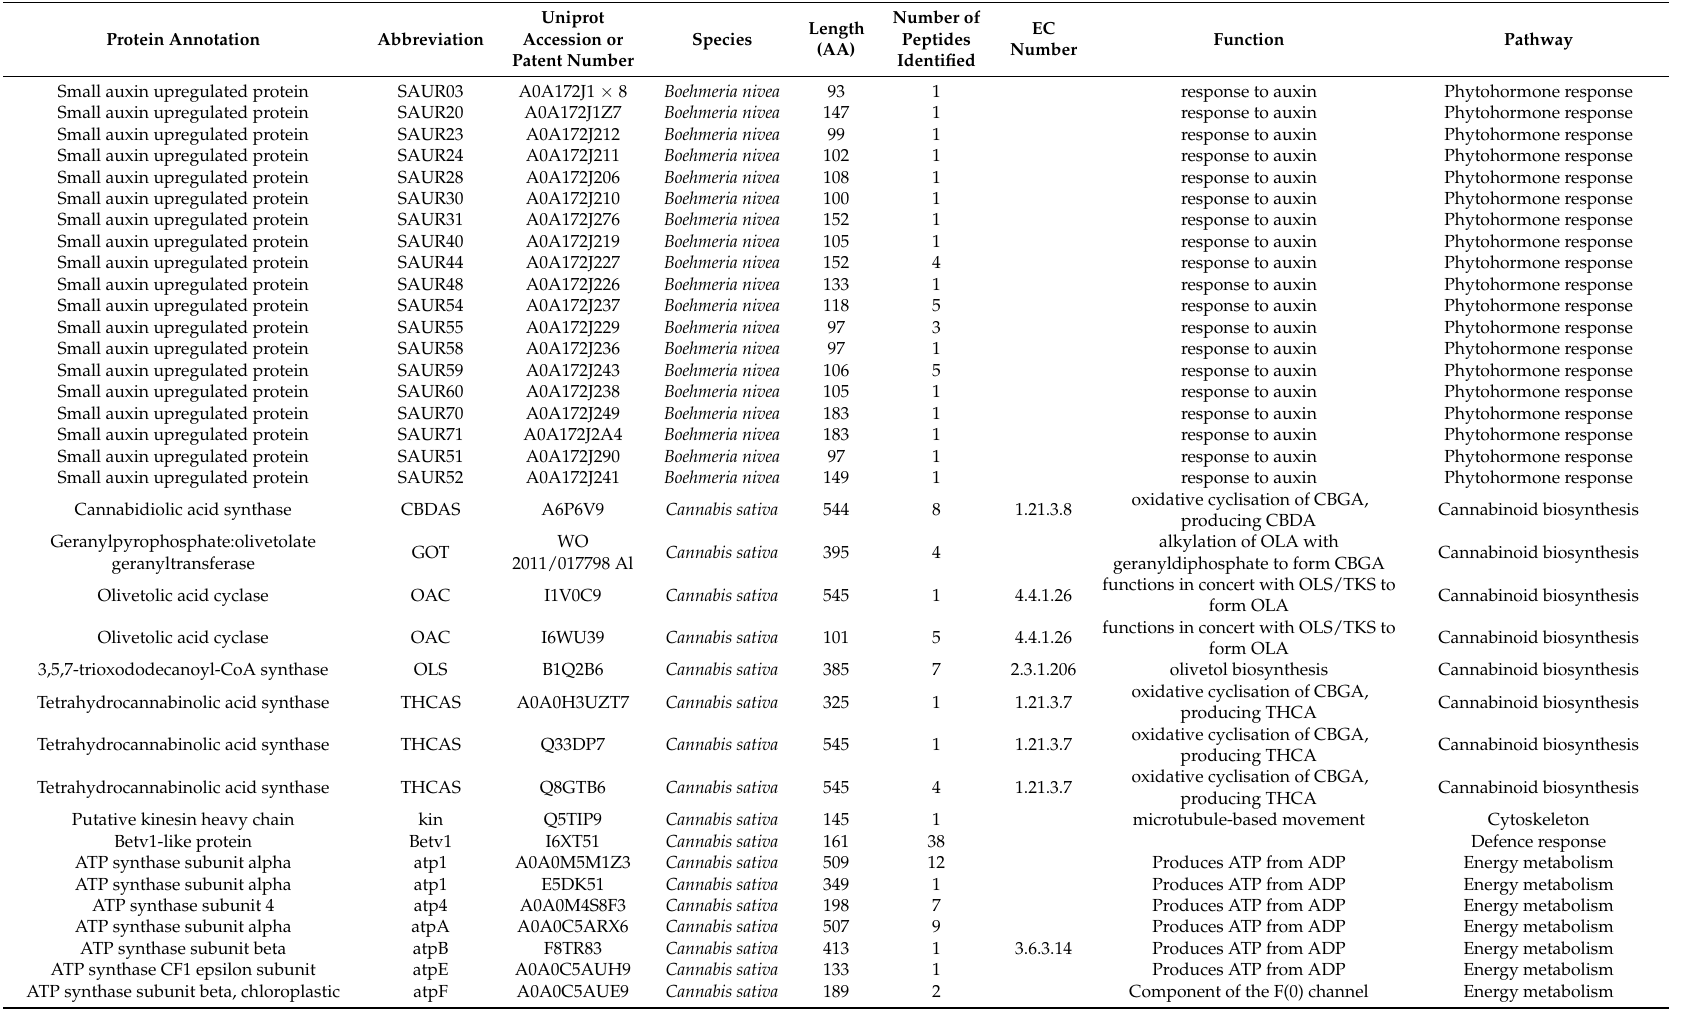
Table 3. List of proteins identified in medicinal cannabis apical buds and trichomes by bottom-up